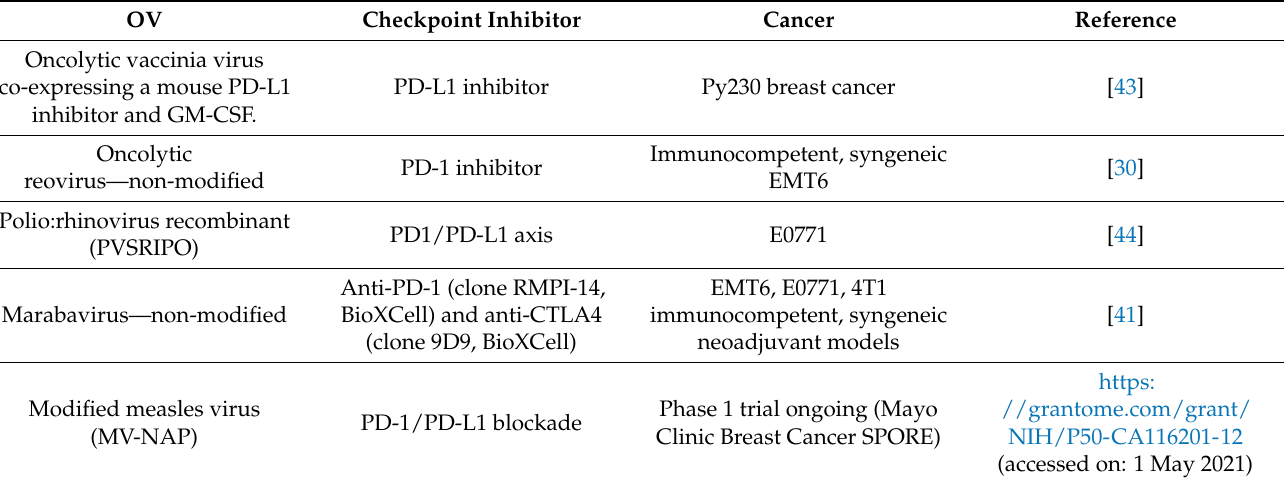
Table 1. Combination of oncolytic viruses and checkpoint inhibition in breast